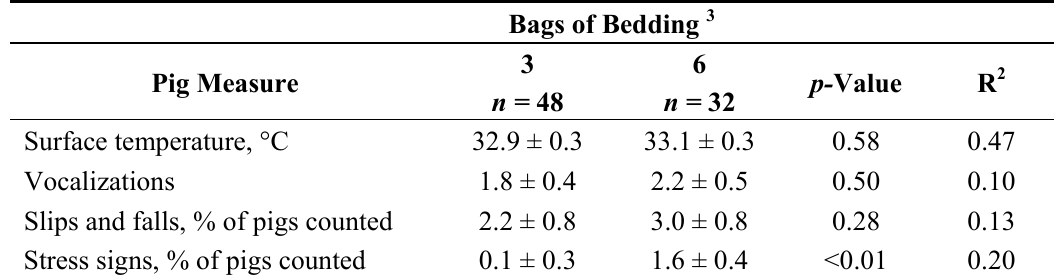
Table 2. Experiment 1. Bedding level by pig measure LSMeans (±SE) measured 1 during unloading for market weight pigs 2 .